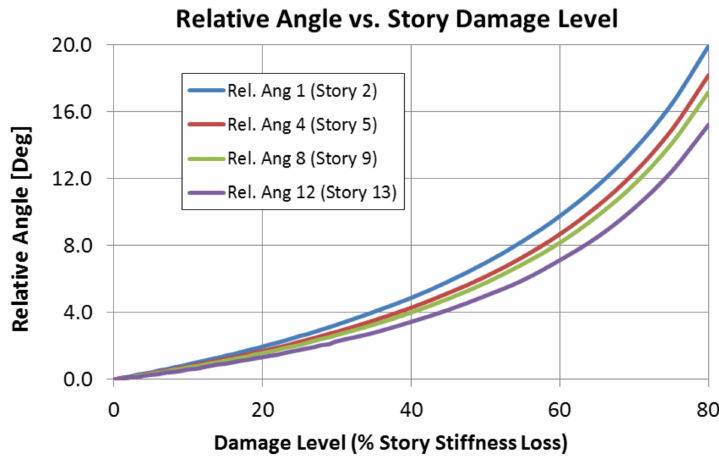
Figure 11. Reference damage curves obtained for several